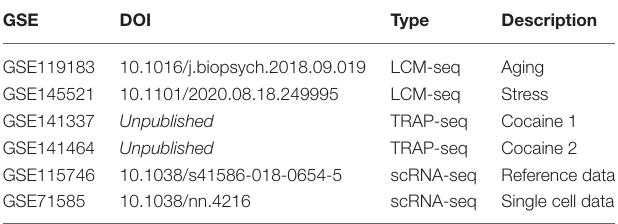
TABLE 2 | Datasets analyzed in this